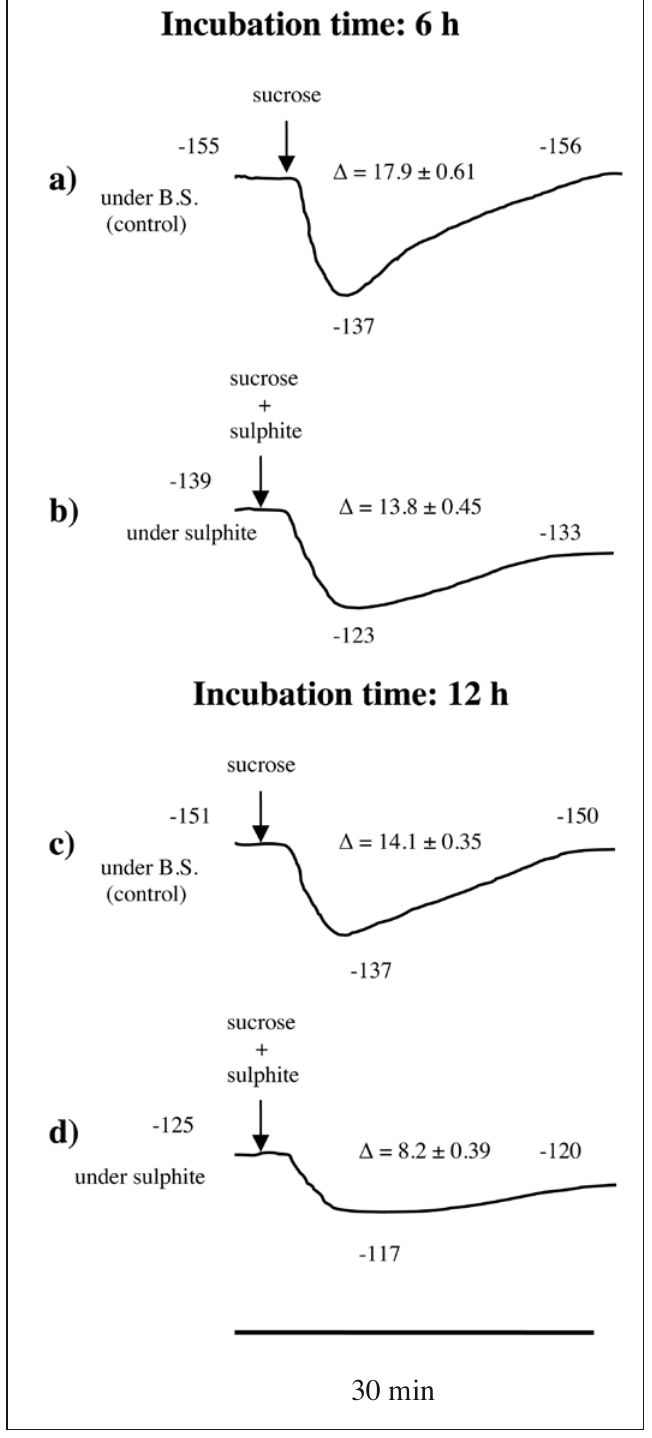
Fig. 5 - Long-term treatments, after 6 h and 12 h of incubation in B.S. and/or sulphite. All measurements were carried out in light. Numbers preceded by - are negative mV. Electrophysiological traces are representative of five equivalent measurements. Δ is the depolarization (mV) as the mean of five measurements ±